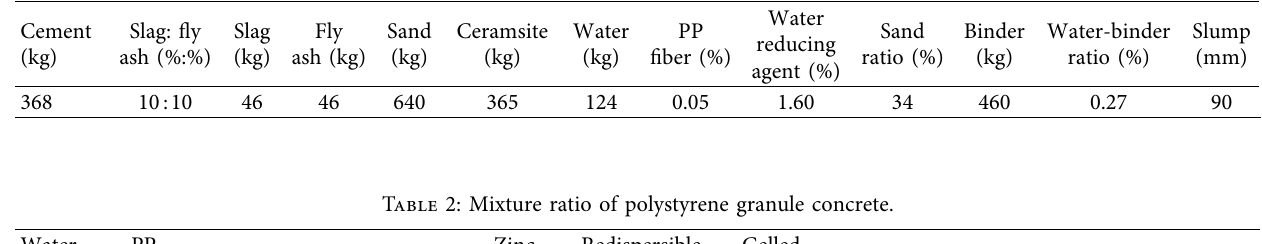
Table 1: The optimal mixture ratio of lightweight aggregate concrete.